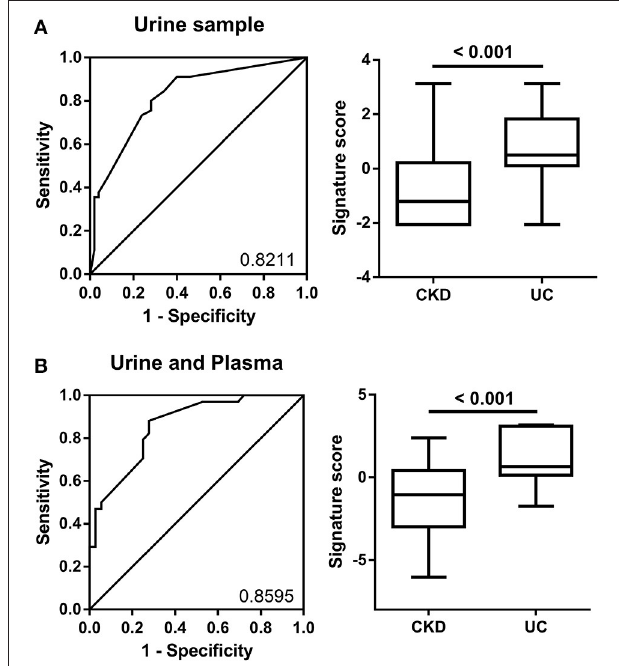
FIGURE 4 | ROC curve analysis of miRNA combinations. (A) ROC curve analysis for miR-1274a, miR-19a-5p, miR-30a-5p, and miR-708-5p in urine was shown to distinguish patients with CKD + UC from those with CKD. (B) The ROC analysis for eight miRNAs (4 in urine-miR-1274a, miR-19a-5p, miR-30a-5p and miR-708-5p, and 4 in plasma-miR-155-5p, miR-19b-1-5p, miR-210 and miR-636) was shown to distinguish patients with CKD + UC from those with CKD. The box plots show the two prediction models distribution that combine the miRNA expression levels from the training group.